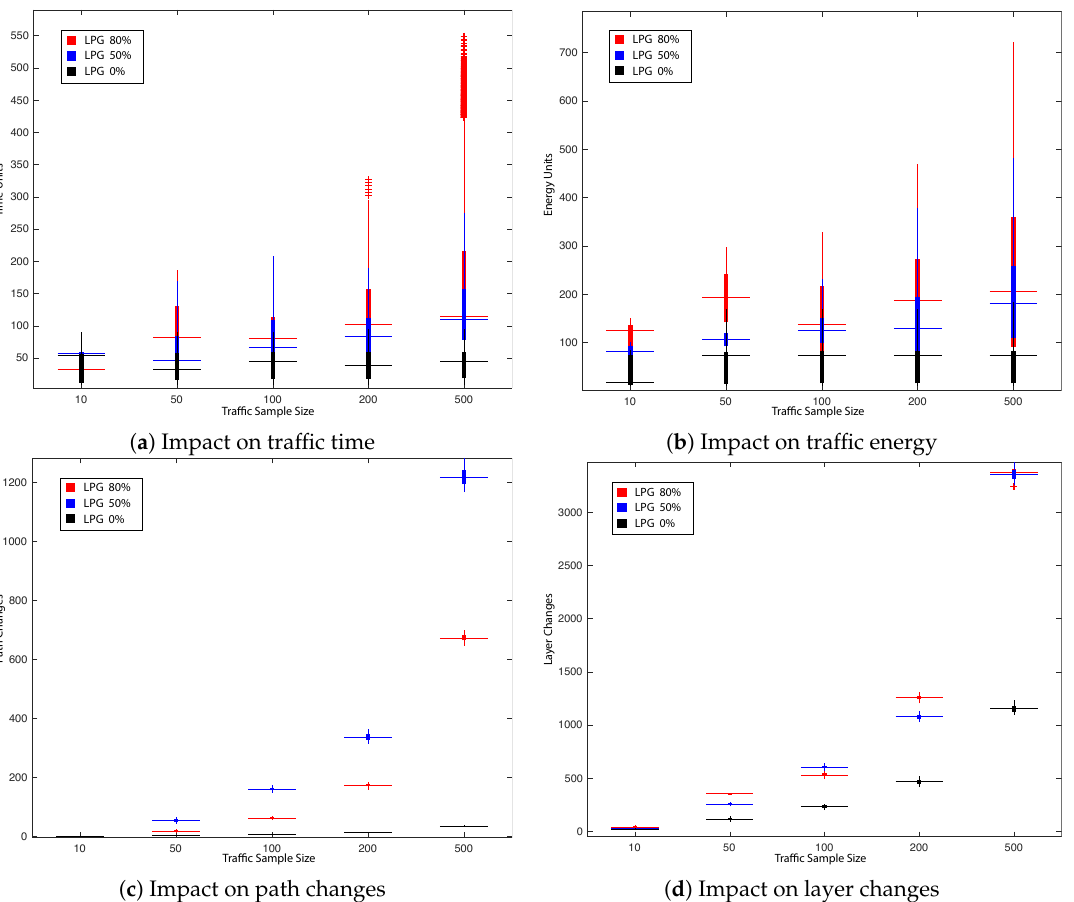
Figure 10. Impact on traffic performance by varying T l im in Local Pheromone Guided (LPG) (80%, 50%, 0%). Table 4. Impact on traffic performance from varying traffic threshold in LPG (80%, 50%,